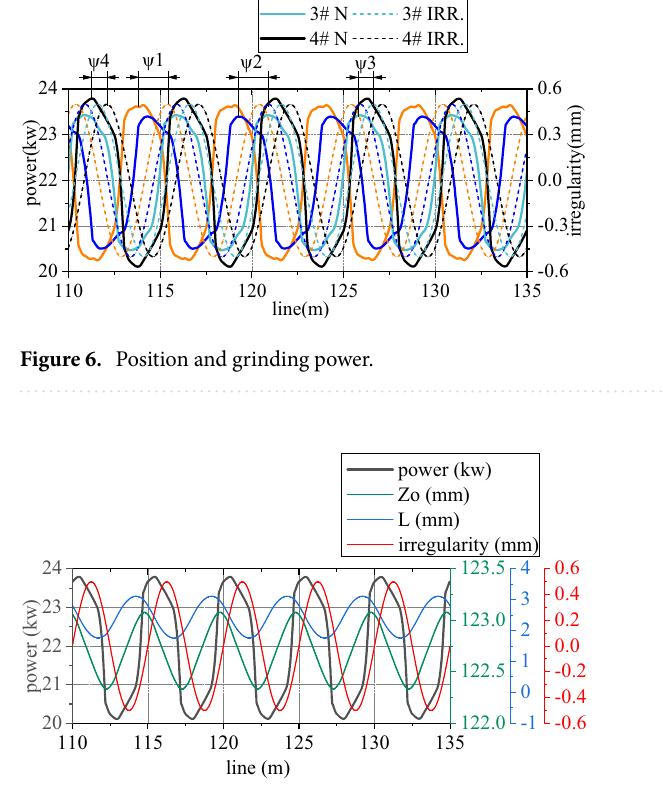
Figure 7. Grinding power and influence factor.